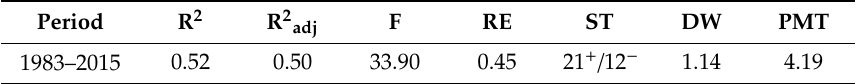
Table 3. Statistics of the leave-one-out cross-validation method for the precipitation py AMJ + AMJ reconstruction using linear regression. R 2 : Explained variance, R 2 adj : Adjusted explained variance,